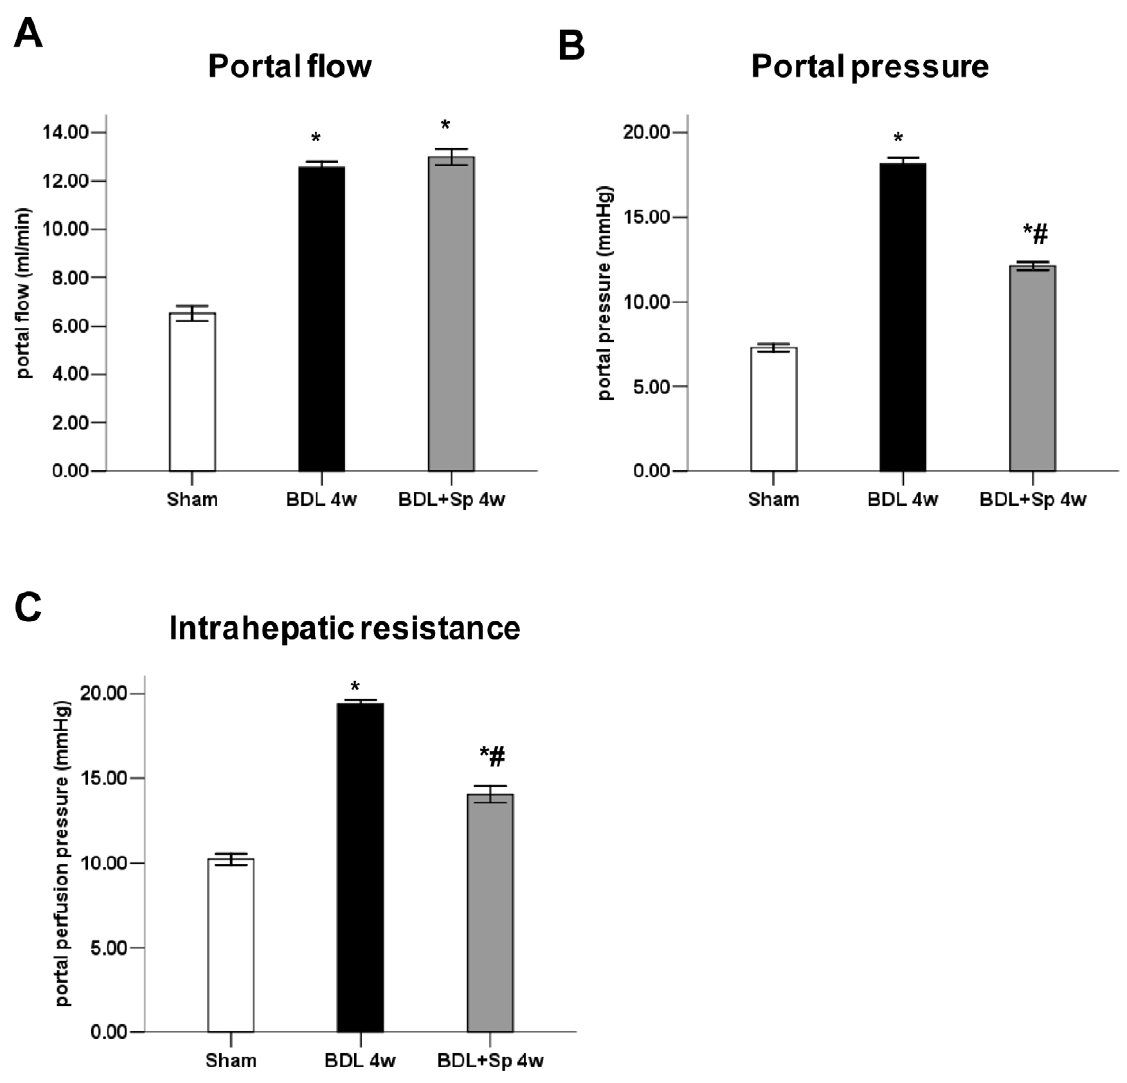
Figure 7. Spironolactone (Sp) improves portal pressure and lower portal vein resistance in BDL- treated rats. (A) Quantification of portal flow in the sham, BDL and BDL + Sp groups. (B) Portal pressure, (C) intrahepatic resistance in situ liver perfusion (20 ml/min) in sham-opreated rats, untreated cirrhotic BDL rats, and cirrhotic BDL rats treated with Sp. * p , 0.05 compared to the Sham group. # p , 0.05 compared to the BDL groups.